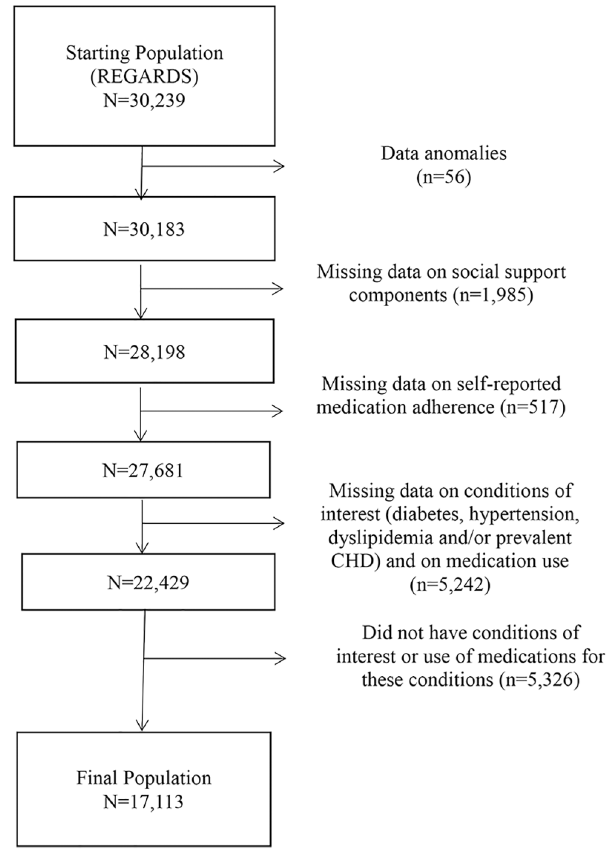
Fig 1. Flow chart with exclusion